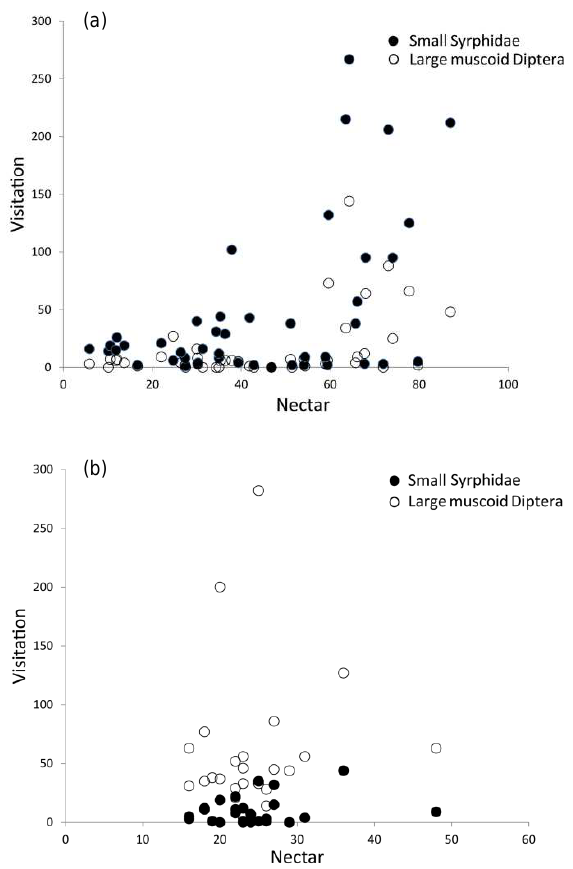
F IGURE 4. Relationship between the number of visits and nectar availability (percentage of flowers per umbel bearing nectar on the day’s last photograph) on a) US parsnips and b) NZ parsnips for large calyptrate flies (US: P< 0.001*, NZ: P= 0.75, GLM negative binomial) and small syrphids (US: P= 0.01*, NZ: P= 0.93 GLM negative